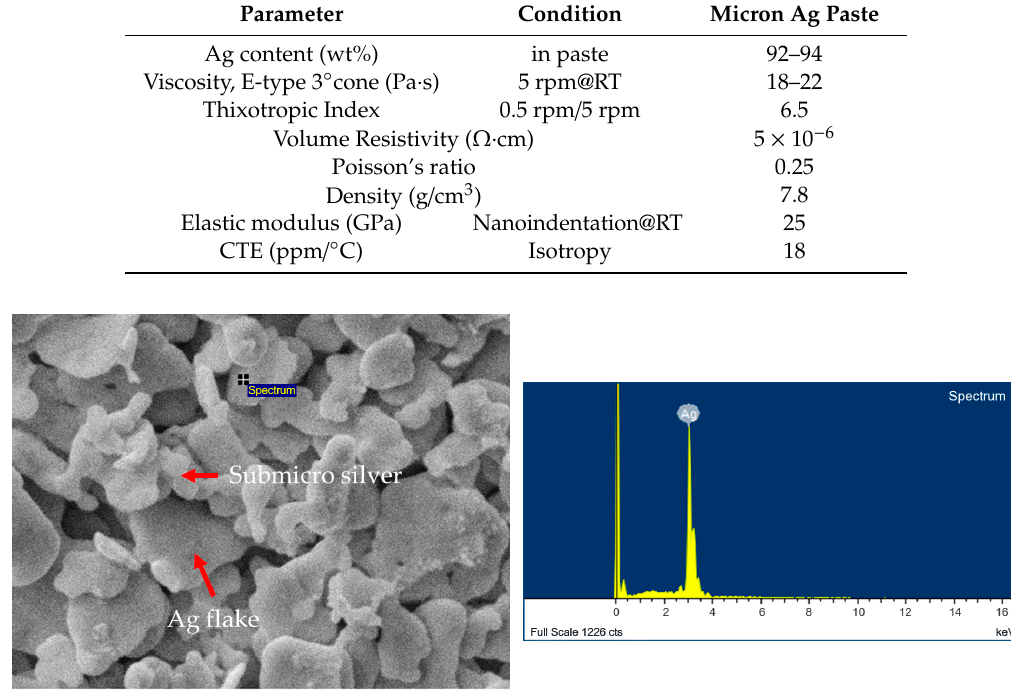
Figure 1. Details of die attachment samples: ( a ) Ti/Ag plated silicon dies; ( b ) the die attachment structure consisting of a Cu substrate, micron silver paste and one side polished die; ( c ) the curing process of micron silver joints.